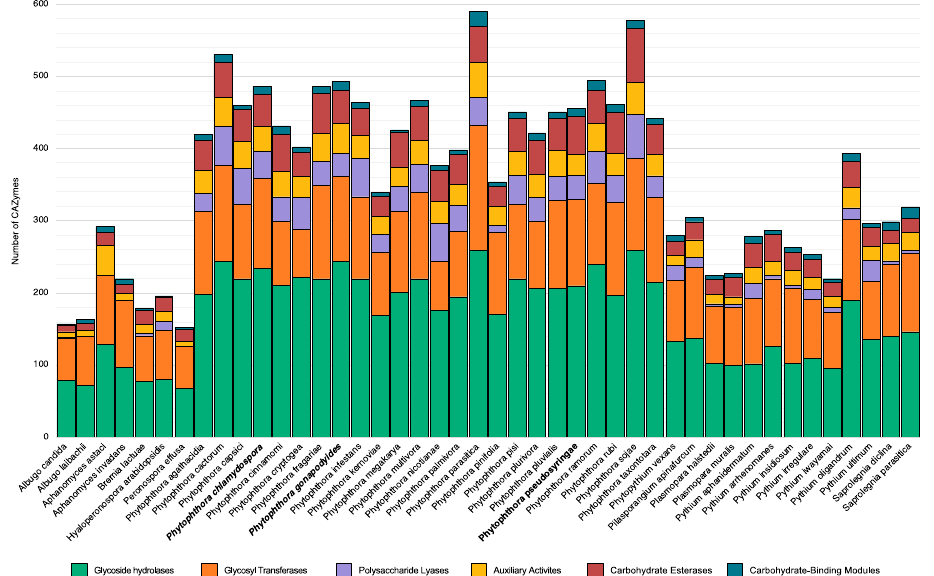
Figure 4. Distribution of CAZymes across 44 oomycete genomes. The arsenal of carbohydrate active enzymes in Phytophthora species is larger than what is observed in other oomycete species. In particular the difference in glycoside hydrolase repertoire is noticeable.